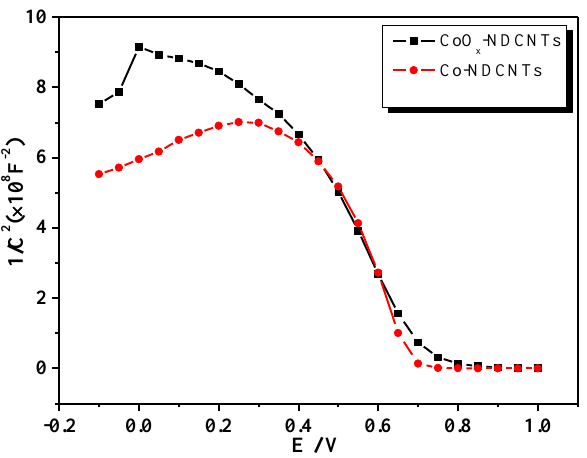
Figure 5. Mott–Schottky patterns of CoO x –NDCNTs and Co–NDCNTs samples. Photogenerated electron-hole separation and electron transfer can be studied by means of electrochemical characterization. Photocurrent responses of g-C 3 N 4 , CoO x –NDCNTs and Co-NDCNTs are shown in Figure 6a. It can be seen that under the excitation of visible light, both samples can quickly show a stable photocurrent response, indicating the existence of photo-generated carriers in the samples. Compared with g-C 3 N 4 , the CoO x –NDCNTs and Co–NDCNTs sample shows the higher photocurrent response, and the photocurrent intensity of Co–NDCNTs sample is about 3.0 times that of g-C 3 N 4 . The results show that the photogenerated electron-hole pairs in the Co-NDCNTs can be more e ff ectively separated than those in g-C 3 N 4 . EIS was further aimed at measuring the charge transfer resistance that controls the charge transfer kinetics of the redox probe at the interface of the photocatalyst [54]. The Nyquist plots for pure g-C 3 N 4 , CoO x –NDCNTs and Co–NDCNTs are shown in Figure 6b. The radius of the Nyquist curve is proportional to the resistance of the electrode surface, and the smaller the radius is, the smaller the resistance of the electrode. From the Figure 6b, it can be seen that the R ct of CoO x –NDCNTs, Co–NDCNTs are much smaller than that of pure g-C 3 N 4